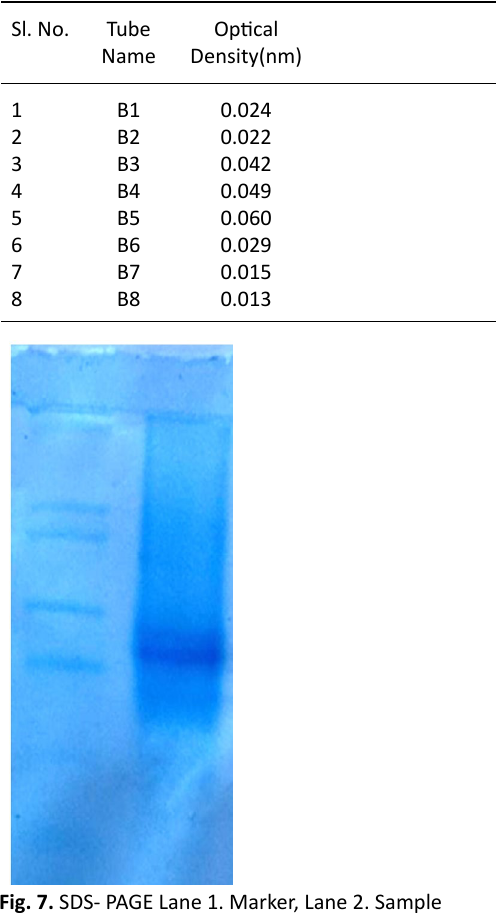
Table 2. OD value of fractions obtained using column